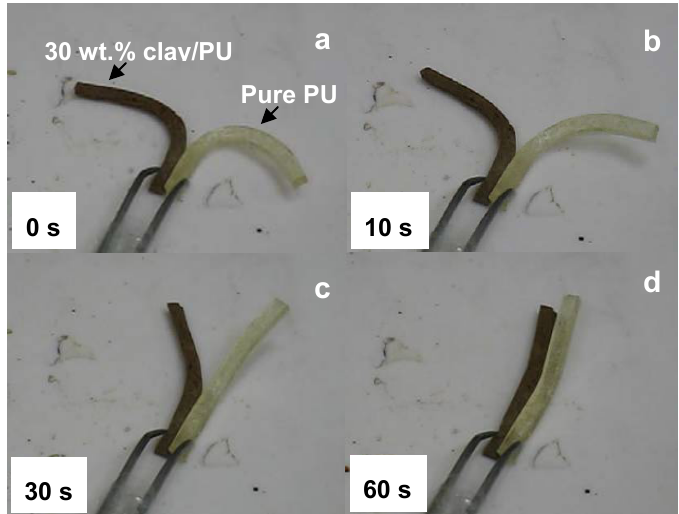
Figure 8. Recovery of shape memory samples heated on a hotplate with a surface temperature of 80